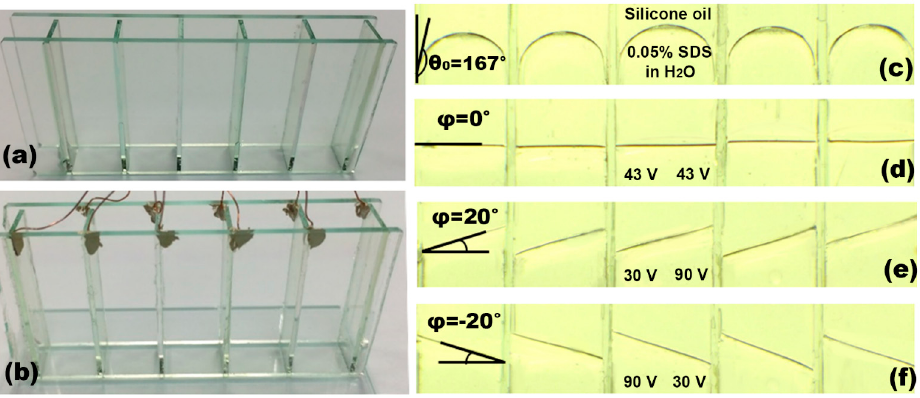
Figure 10. Demonstration of the dip-coatable ion gel fabrication for 5 × 1 arrayed liquid prisms as an